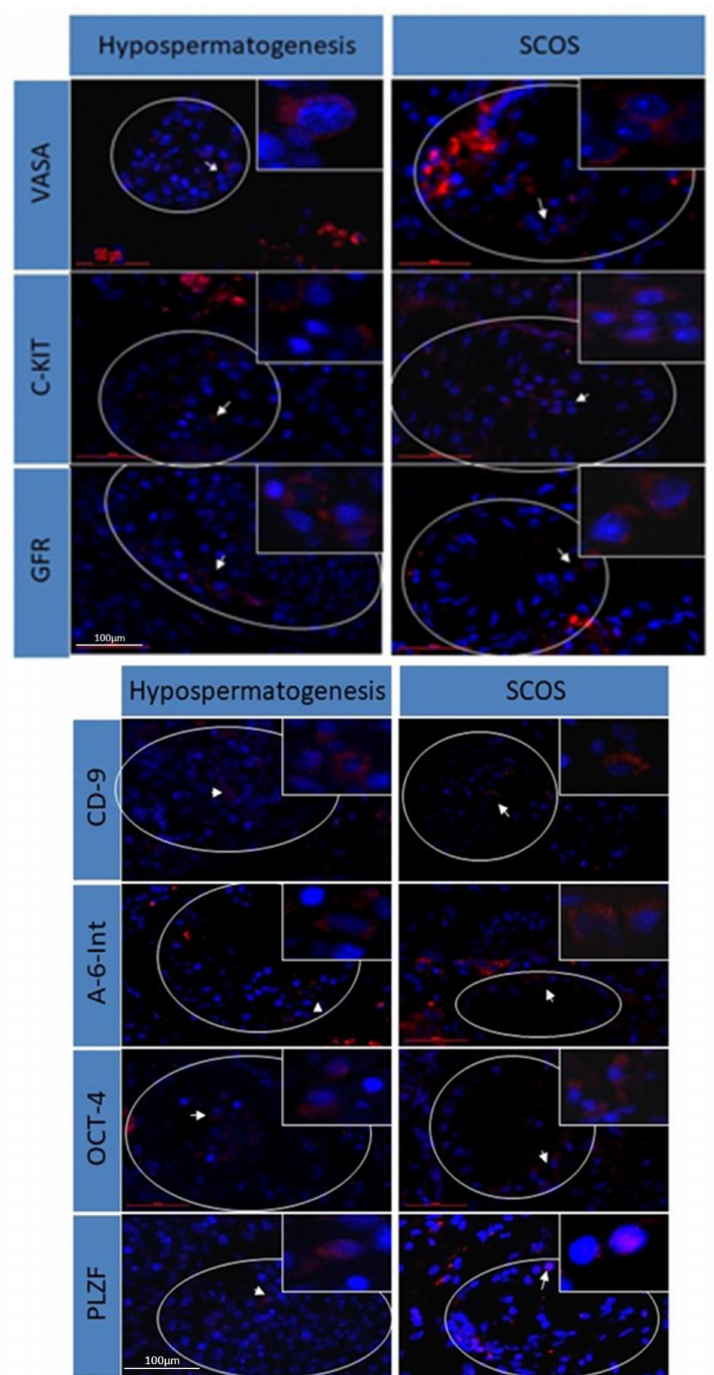
Figure 1. Immunofluorescence staining in hypospermatogenesis and SCOS testicular biopsies for the presence of premeiotic markers. Testicular biopsies with hypospermatogenesis and SCOS histology were examined for the presence of premeiotic cells by immunofluorescence staining using specific primary antibodies for each of the examined premeiotic markers: VASA, c-KIT, GFRa1, CD-9, a-6-Integrin, OCT-4, and PLZF. Blue—cell nuclei stained with DAPI, red—specific marker staining. Scale bar: 100 µ